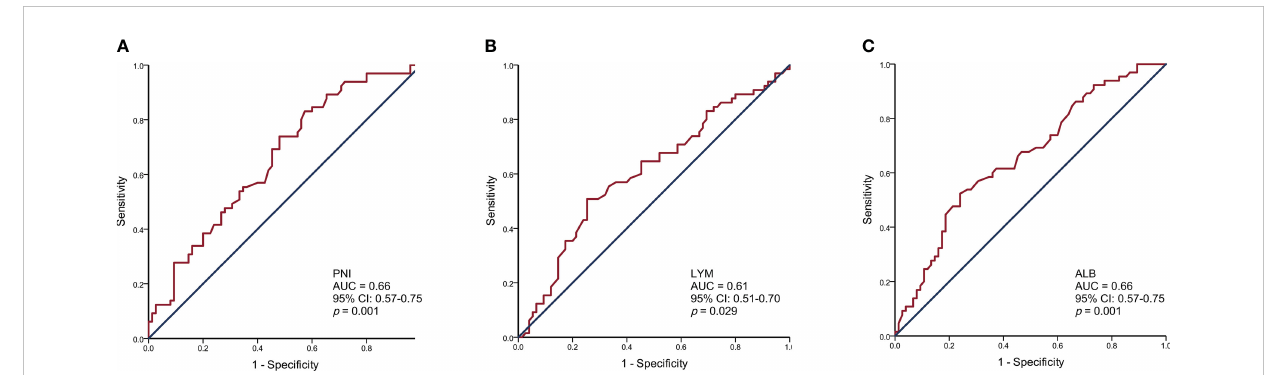
FIGURE 1 Receiver operating characteristic curve analysis for the prognostic nutritional index (A) , lymphocytes (B) , and albumin (C) to predict the prognosis of SCLC